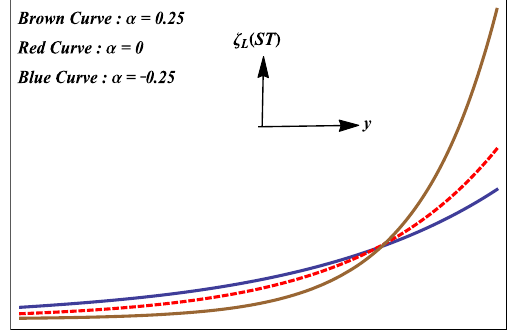
Fig. 7 ˜ ζ L ( = ζ L ( ST ) in the diagram) vs. y for M = 1, (cid:9) = − 1 and m 5 = 0 . 5 k